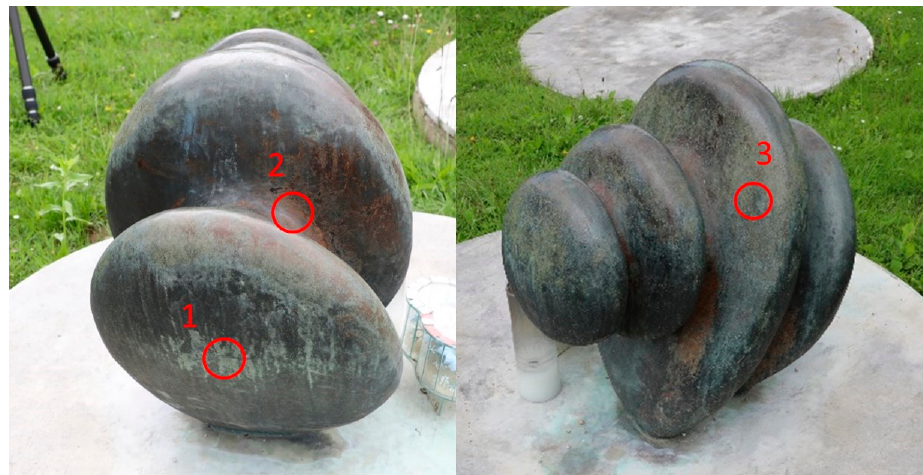
Figure 2. Sculpture at Memorial Cemetery with indicatedtest areas 1–3.